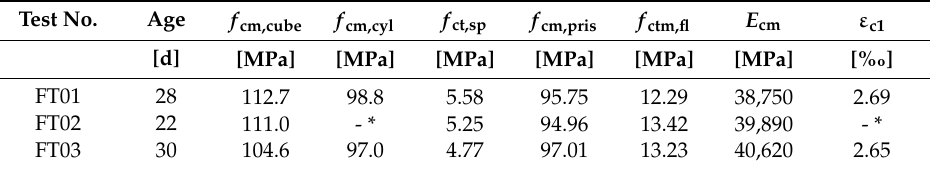
Table 4. Material properties of hardened concrete at the day of